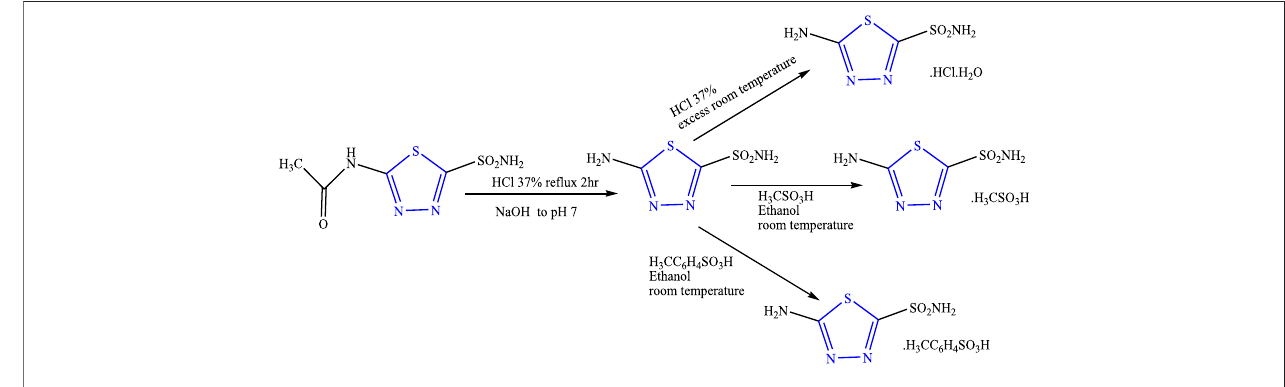
FIGURE 9 | Systematic scheme for synthesizing 5-amino-2-sulfonamide thiadiazole salts.